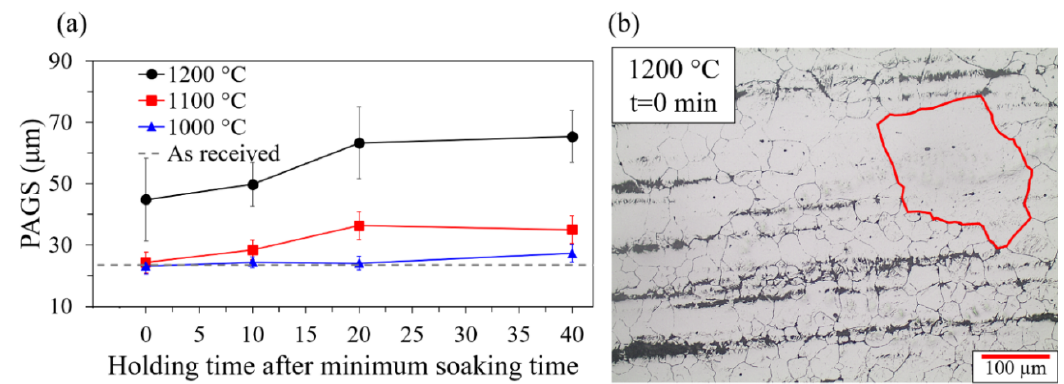
Figure 3. ( a ) Effect of temperature and holding time on austenitic grain; and ( b ) PAGS microstructure after austenitizing at 1200 °C with 0 min of holding time, indicating the presence of abnormal grain. Highlighted grain has a mean size of 200 µm and the matrix 45 µm.